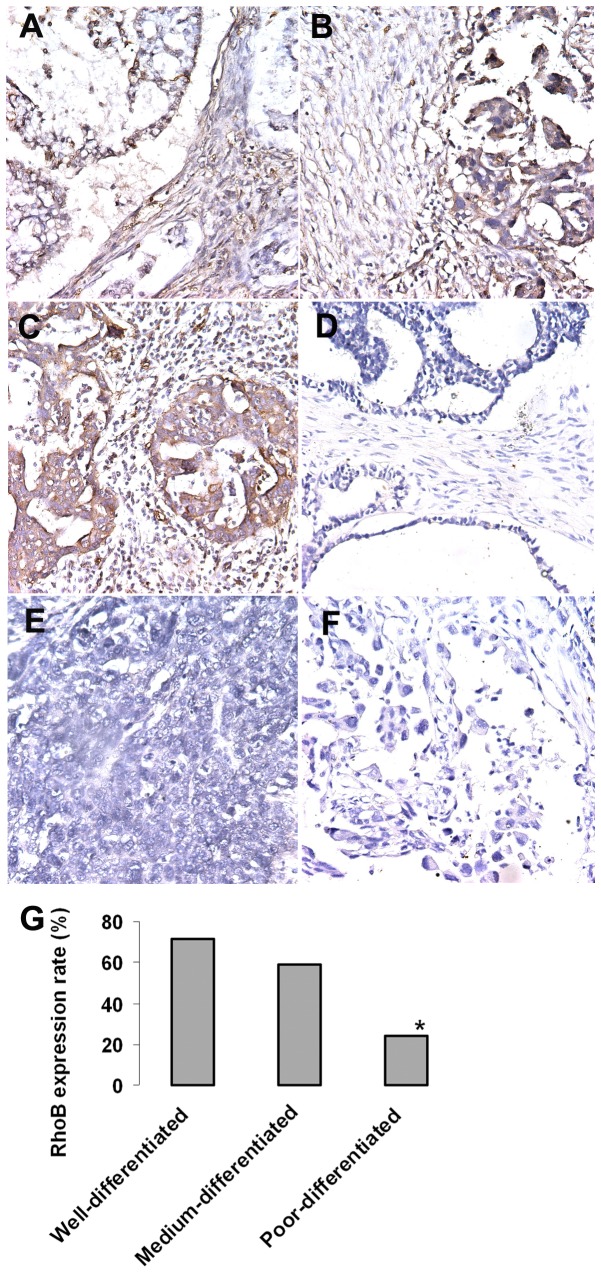
RhoB gene expression and ovary carcinoma differentiation.RhoB expression levels were analyzed respectively in well-, medium-, and poor-differentiated ovarian cancer using immunohistochemistry staining of individual paraffin sections. RhoB is expressed in the cytoplasm of monolayered ovarian surface epithelial cells for well-differentiated ovary caicinoma (AB); in medium-differentiated tumor, RhoB is expressed in the monolayered and multilayered regions of epithelium tumor (CD); and RhoB is lost in the multilayered region of epithelium for poor-differentiated tumor (EF). (G) It is clear that Poor-differentiated tumors had a significant reduction in the expression of RhoB (80% reduction) than medium differentiated (44% reduction) and well differentiated ovary cancer (28.5% reduction).